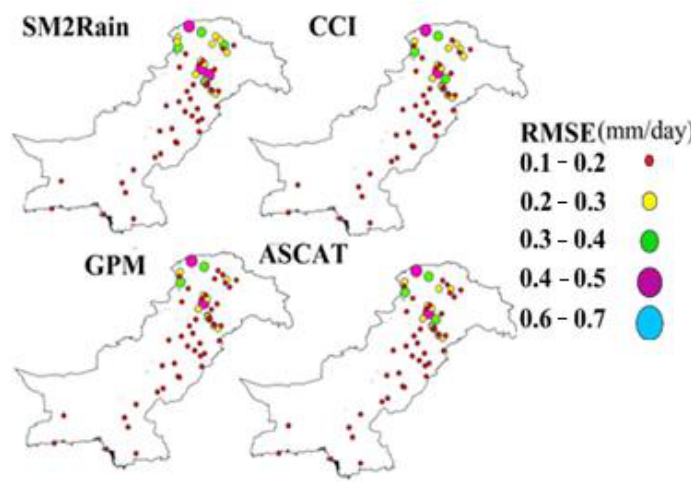
Figure 9. RMSE’s spatial distribution of all SPPs .